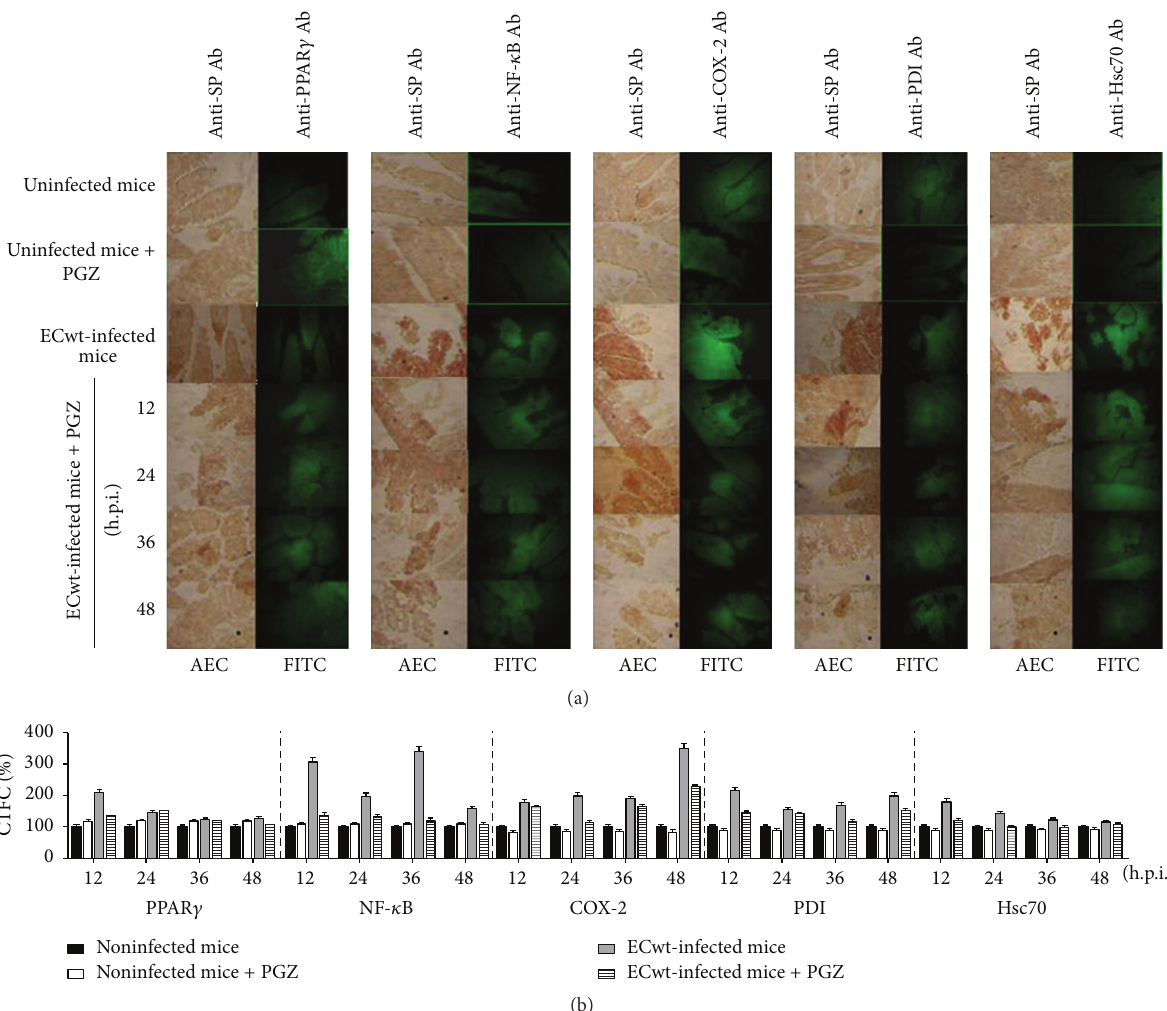
Figure 2: Expression of cellular proteins in villus cells from in vivo ECwt-infected mice treated with PGZ. (a) Mice ( 𝑛 = 3 per experiment) were infected or not with ECwt and then treated or not with PGZ. Villi isolated from mice were treated for immunochemistry analysis using primary antibodies against rotavirus structural proteins (SP) and secondary HRP-conjugated antibodies and AEC as a substrate. The same slides were subjected to immunofluorescence analysis using the indicated primary antibodies (Ab) and secondary FITC-conjugated antibodies. Representative micrographs are shown. (b) Fluorescence of cells positive to the cellular proteins indicated was measured in randomly chosen triplicate fields per slide using the ImageJ program, and the corrected total cell fluorescence (CTCF) values converted into percentage values are shown as mean ( ± SD) from three independent experiments performed in